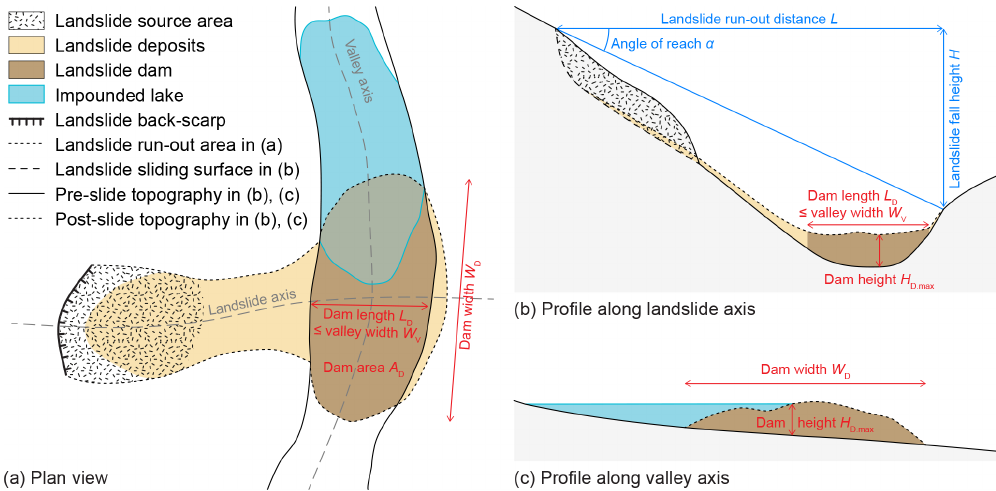
Figure 4. Sketches of a landslide dam with the measured dimensions (adapted from Toccani Stefanelli et al., 2018): (a) plan view for measuring dam area A D , dam width W D , dam length L D , and valley width W V ( L D = W V in case of complete damming of the valley, L D <W V in case of partial damming of the valley); (b) across-valley profile for measuring valley width W V and dam length L D and estimating maximum dam height H D . max , along with landslide fall height H , landslide run-out distance L , and angle of reach α ; (c) along-valley profile for measuring dam width W D and estimating maximum dam height H D . max . The pre-landslide topography is estimated on both profiles by considering the local valley